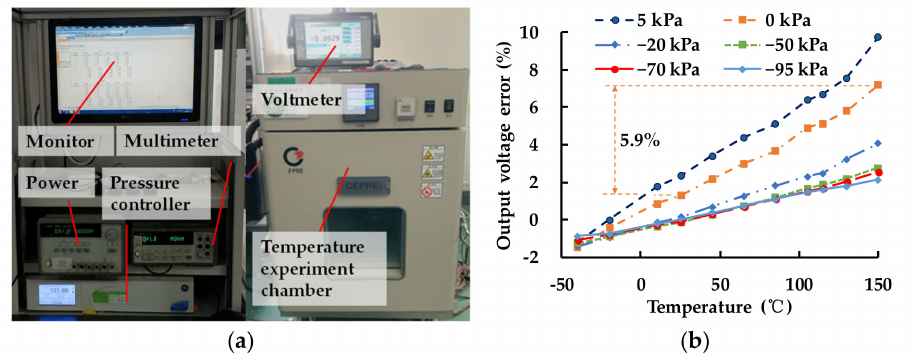
Figure 3. ( a ) MEMS pressure-sensor testing system; ( b ) output voltage errors of the MEMS pressure sensor at different air pressures and